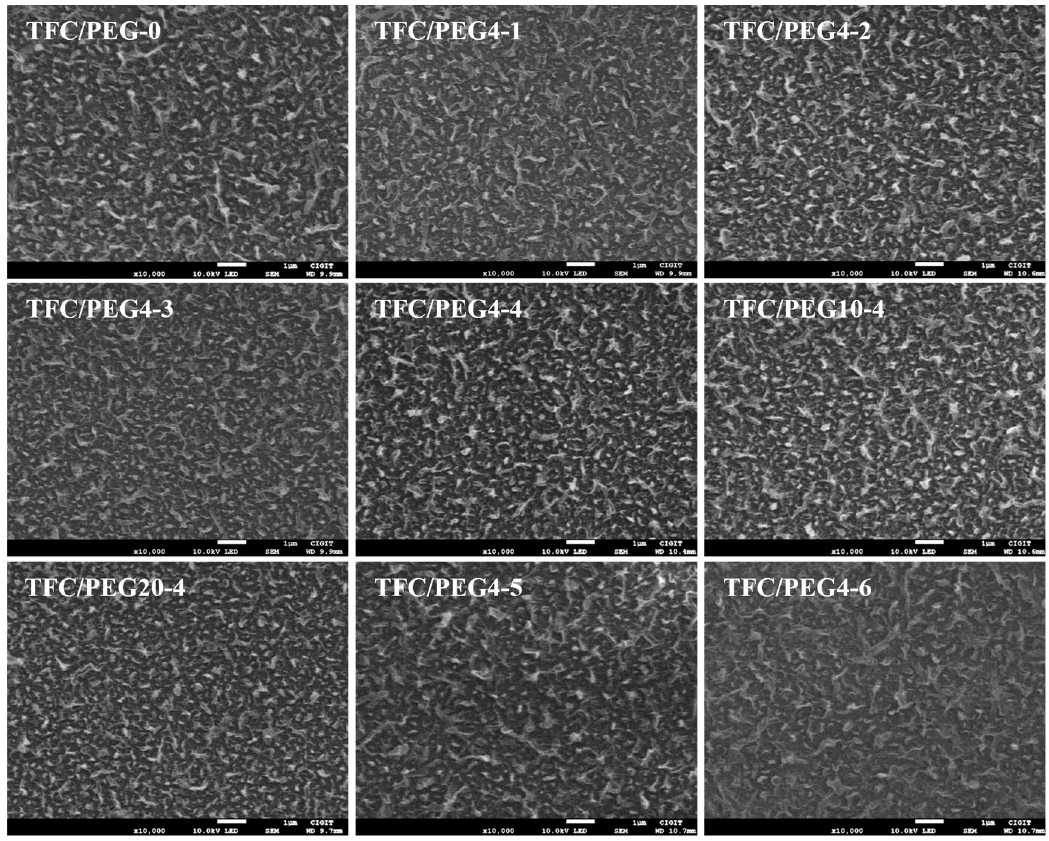
Figure 7. SEM images for top surface of PSU/PEG supported TFC-FO membranes.